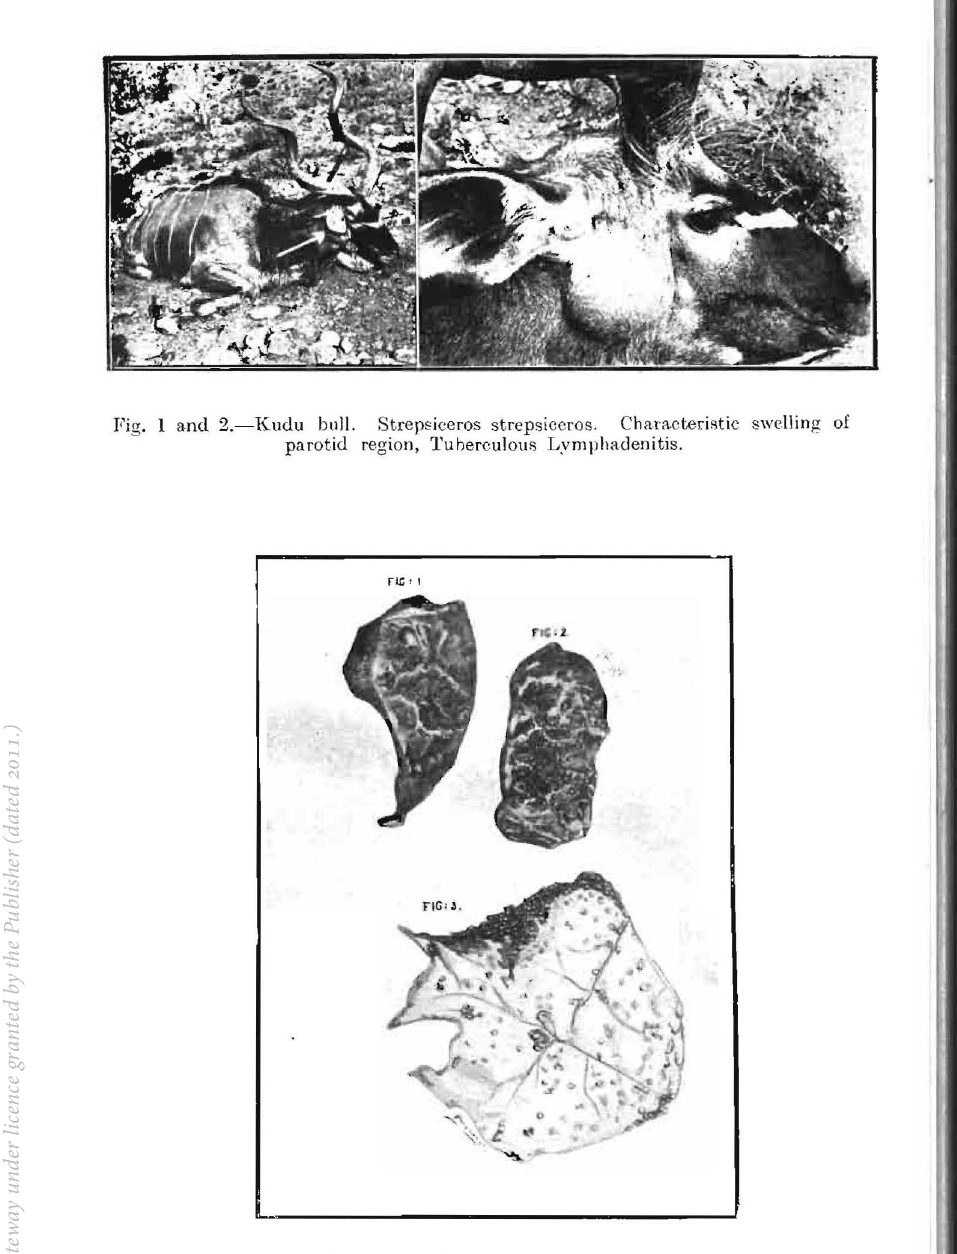
Fig. 3.-Dniker. Sylvicapra grimmi (from drawing). l. and 2.-Portions of lung showing miliary tuhercles on pleura and cut surface. 3.-Peritonium. Miliary tubercles,